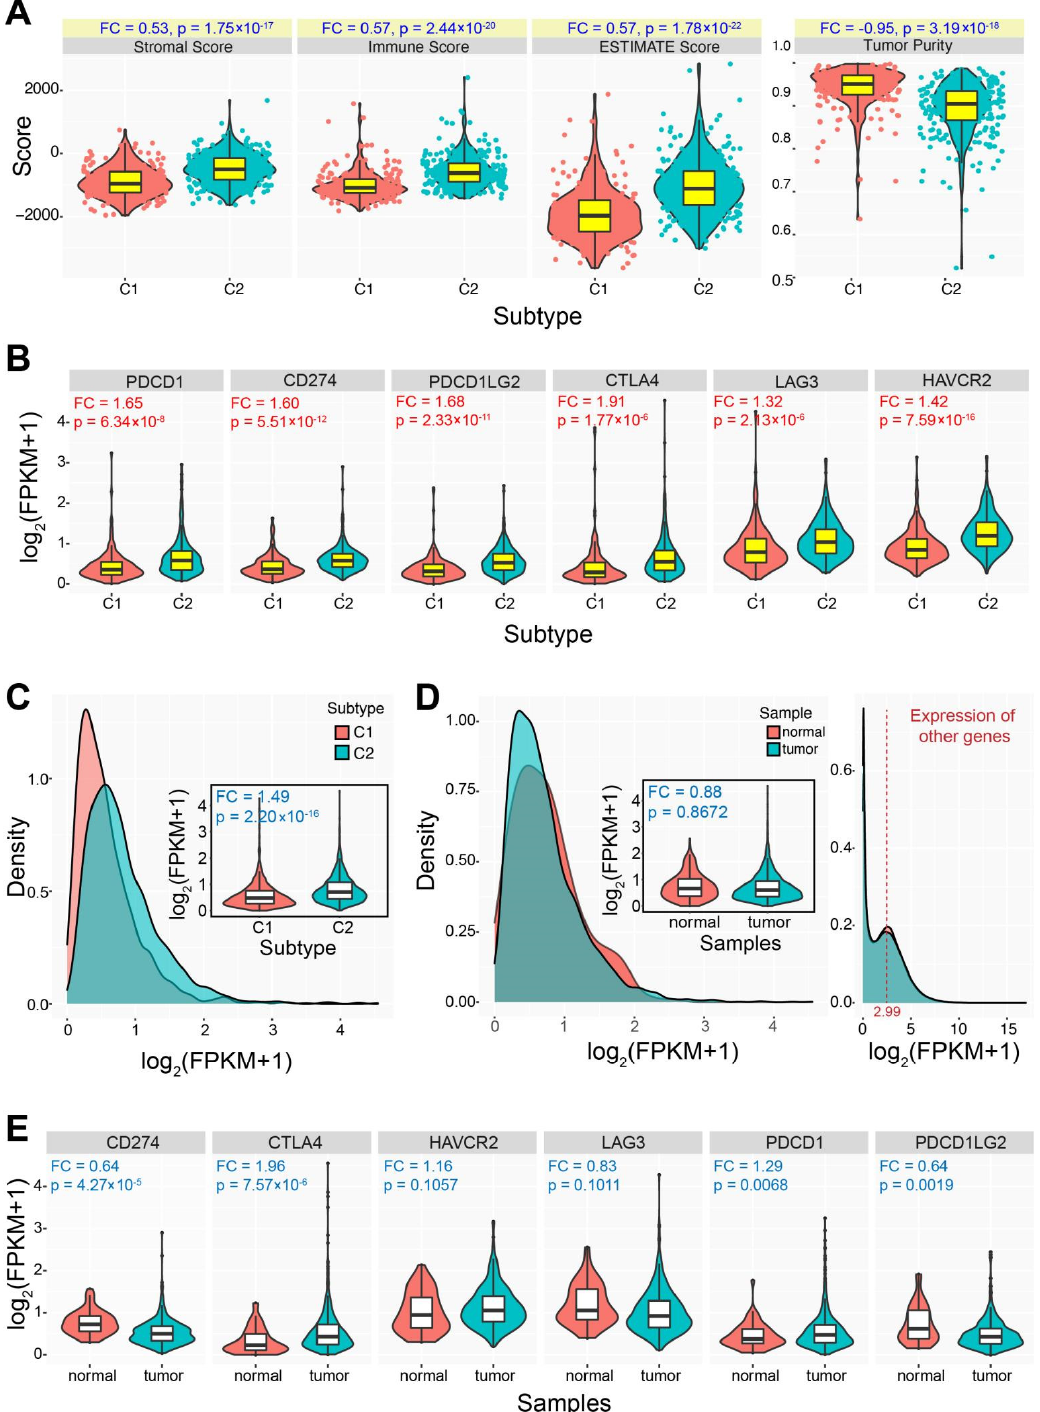
Figure 2. The distributions of immune-related features and genes between the two subtypes. ( A ). The distributions of immune-related features between the two subtypes. The fold change and p values are also presented for each feature. ( B ). Differential expression patterns of several immune checkpoint genes between the two subtypes. ( C ). The whole expression distributions of immune checkpoint genes between the two subtypes, and the fold change and p value are also presented. ( D ). The whole expression distributions of immune checkpoint genes between tumor and normal samples, and the fold change and p value are also presented. The distribution on the right indicates the expression distribution of other genes in PRAD, and the median value is 2.99 EUR. ( E ). The detailed expression patterns of immune checkpoint genes in PRAD, and the fold change and p value are also